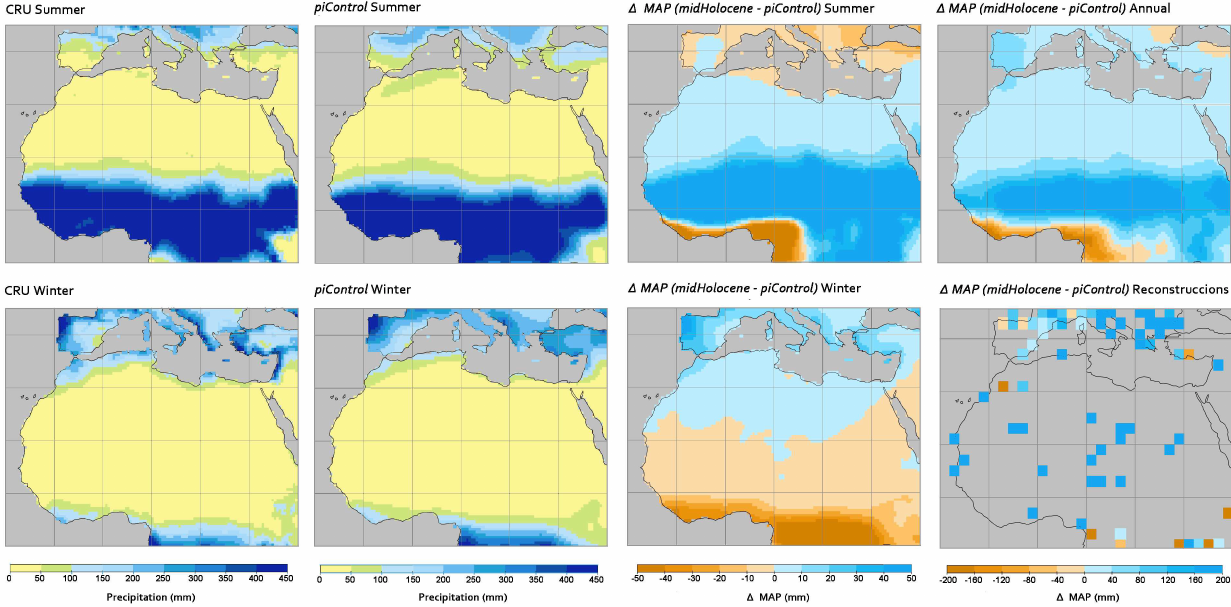
Fig. 2. Observed and simulated modern and palaeoprecipitation patterns. The total summer and winter precipitation from the CRU T3.1 data set (Harris et al., 2014) are compared to ensemble averages of the piControl outputs of the 12 CMIP5 models. The simulated change in precipitation between the mid-Holocene and piControl simulations ( midHolocene - piControl ) is shown based on the ensemble average of the midHolocene outputs of the 12 CMIP5 models. The observed anomalies in mean annual precipitation (MAP) between the mid-Holocene and the present day are average values for 2 ◦ × 2 ◦ grids from the Bartlein et al. (2011) data set.